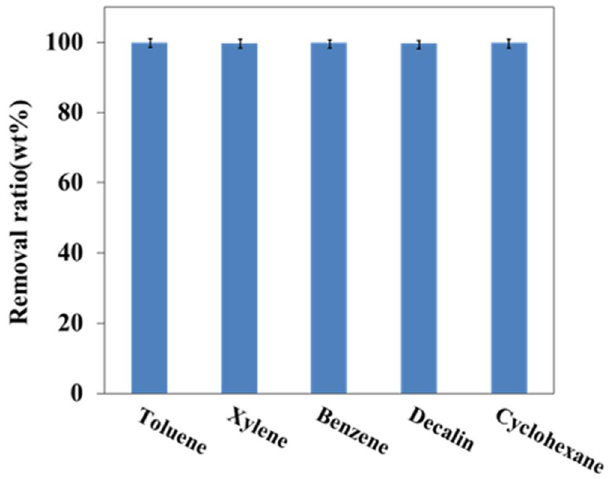
Figure 5. Absorption efficiency of the PS monolith toward emulsions prepared from different oils.